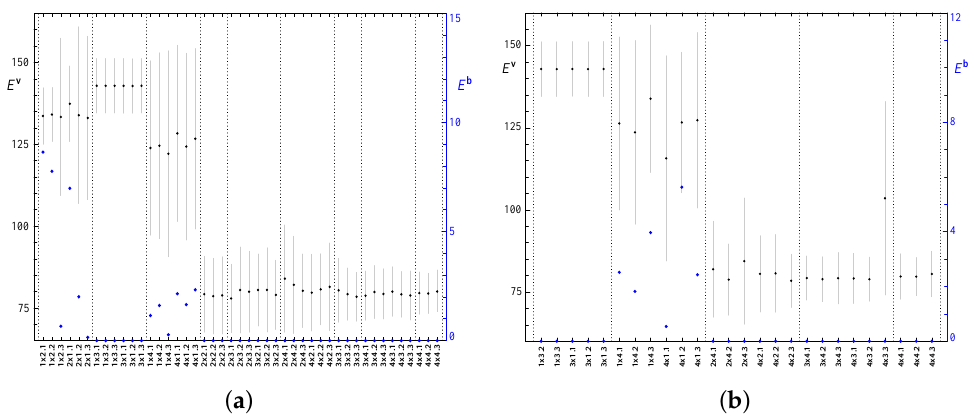
Figure 3. Space- and time-averaged kinetic (smaller black dots, left axis) and magnetic (larger blue dots, right axis) energies for the attractors obtained in the runs with the standard (128 M 1 × 128 M 2 × 97 harmonics), (a), and alternative (256 × 256 × 257 harmonics), (b), resolution. Gray vertical lines: r.m.s. deviations of the space-averaged kinetic energy from their time averages. Thin vertical dotted lines separate the runs into groups of regimes residing in identical periodicity